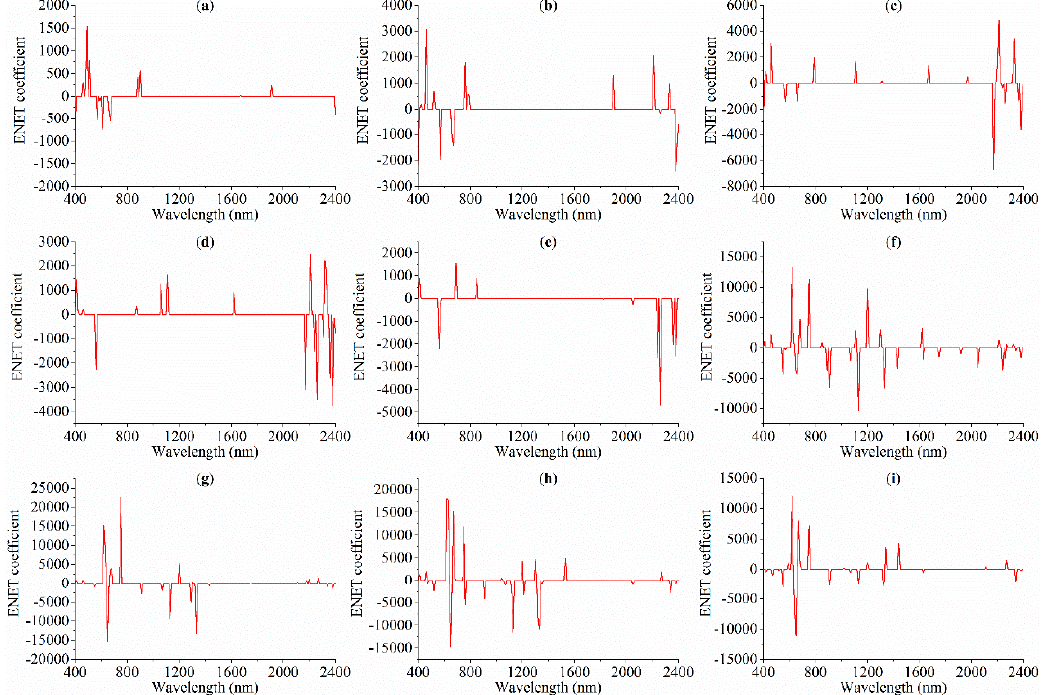
Figure 7. Plots showing ENET coefficients: ( a ) original reflectance (order = 0); ( b ) 0.25-order; ( c ) 0.5-order; ( d ) 0.75-order; ( e ) 1-order; ( f ) 1.25-order; ( g ) 1.5-order; ( h ) 1.75-order; and ( i ) 2-order.